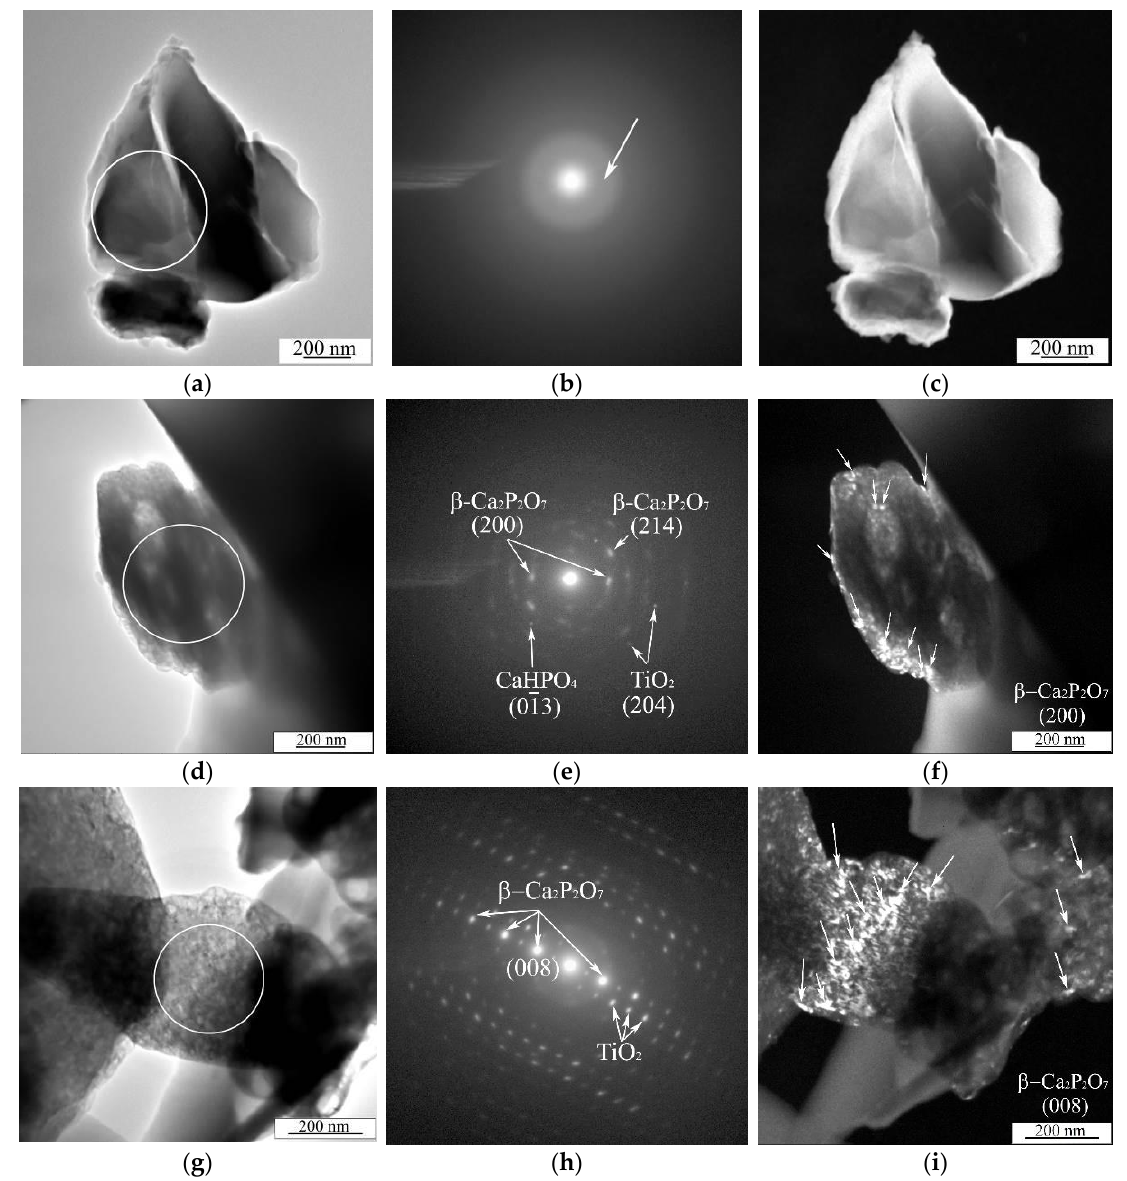
Figure 9. BF TEM ( a , d , g ) and DF TEM ( c , f , i ) images and SAED patterns ( b,e , h ) of the particles of the CaP ( a – c ), Cu-CaP ( d – f ) and Zn-CaP ( e – g ) coatings deposited on Ti at 300 V. The SAED patterns were observed within the regions of interest that are highlighted in BF TEM images.